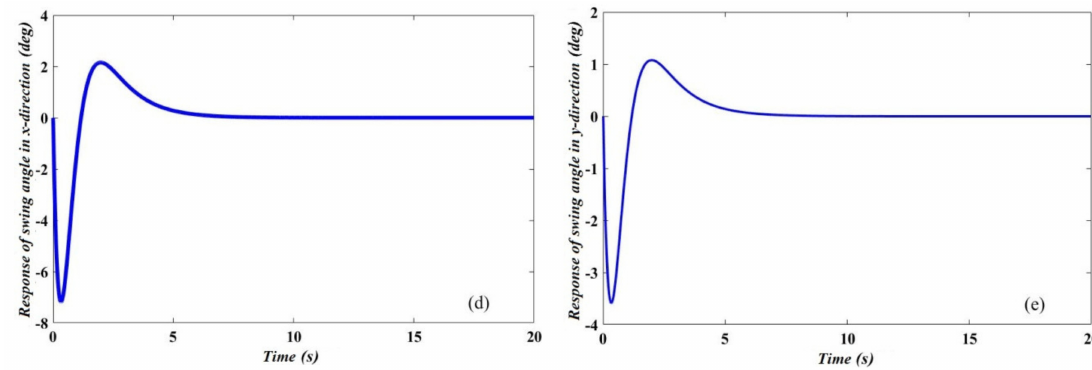
Figure 8. The swing angles when the payload mass is 20